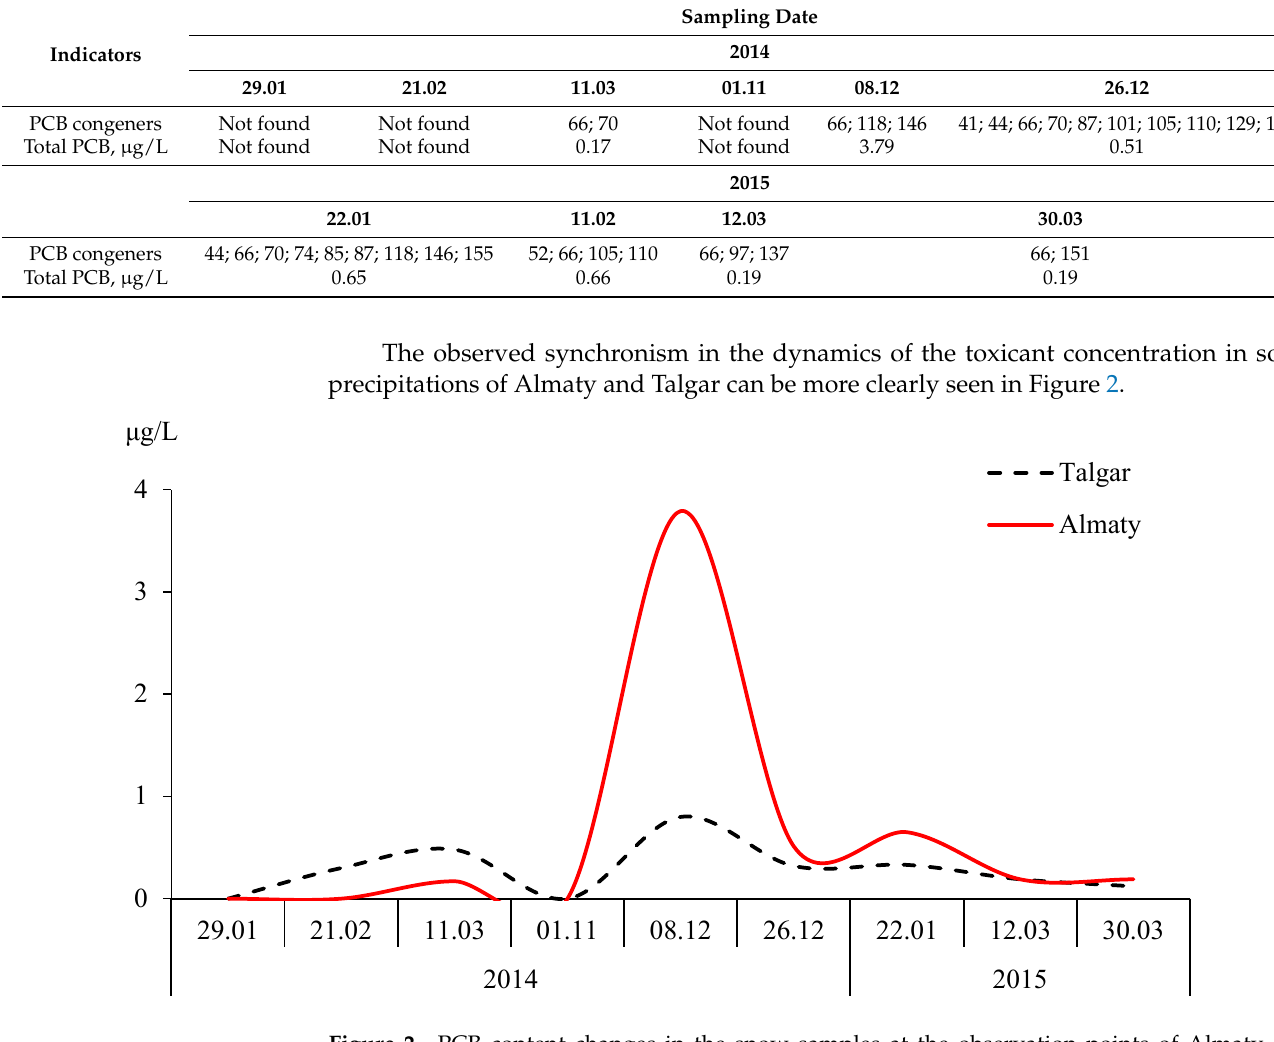
Figure 2. PCB content changes in the snow samples at the observation points of Almaty and Talgar cities.